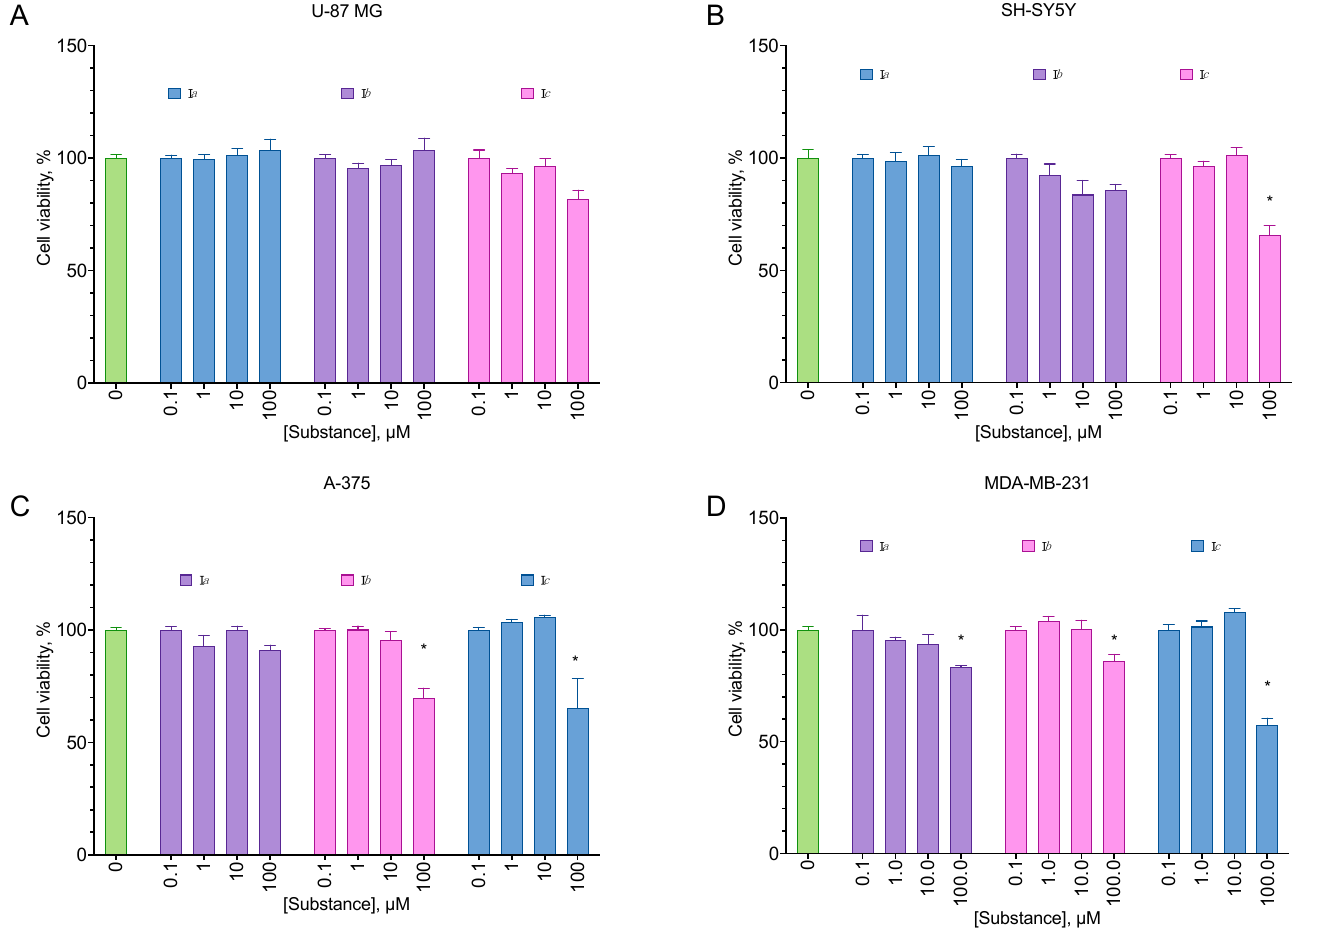
Figure 4. Anti-proliferative activity of the pyridyl urea derivatives for the U-87 MG glioblastoma ( A ), SH-SY5Y neuroblastoma ( B ), A-375 melanoma ( C ), and MDA-MB-231 carcinoma ( D ) cell lines. Negative control cells (100% viability) were treated with 0.5% DMSO. Positive control cells (100% cell death) were treated with 3.6 µ L of 50% Triton X-100 in ethanol per 200 µ L of the cell culture medium. 24 h incubation. MTT test data. Mean ± standard error ( n = 5 experiments). * Statistically significant difference from the control, ANOVA with the Dunnett post-test, p ≤ 0.05